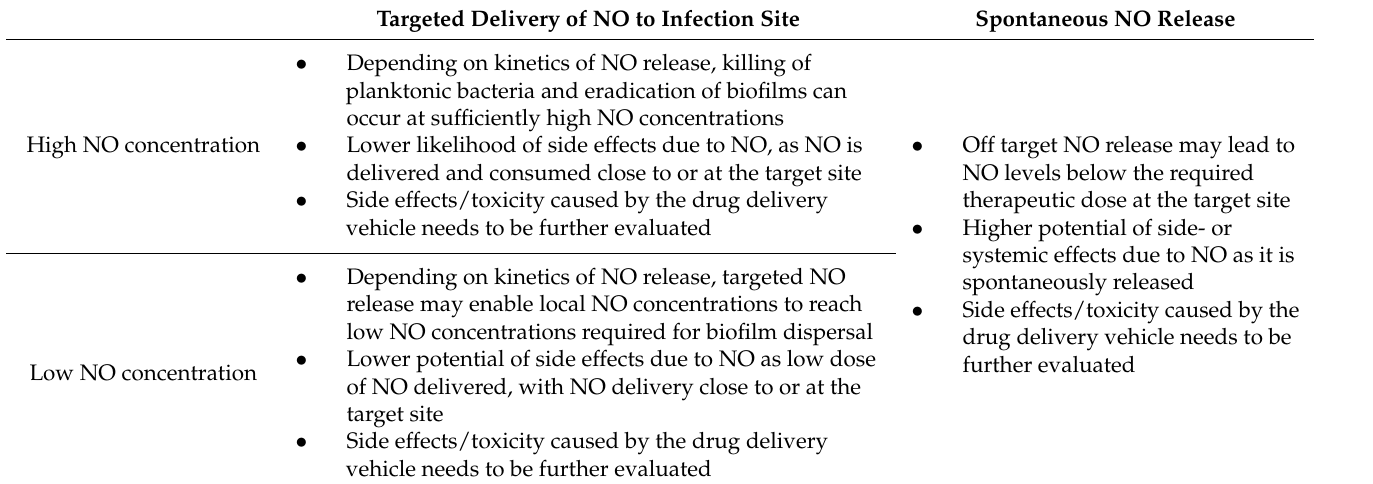
Table 1. Summary of NO concentration and its general effects on antibacterial and anti-biofilm activity and